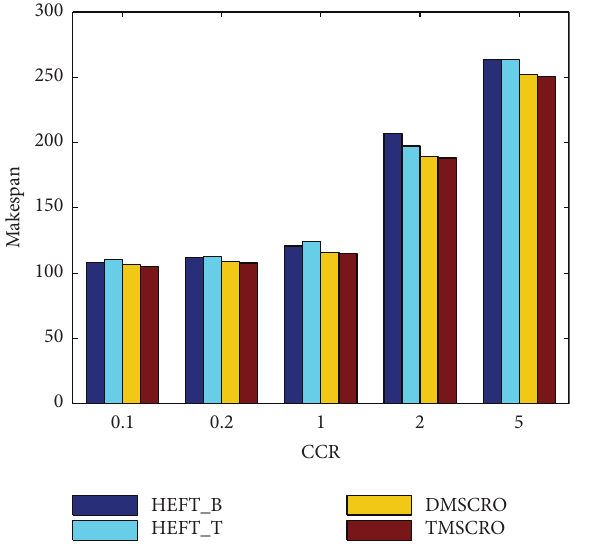
Figure 18: Average makespan for the molecular dynamics code; the number of processors is